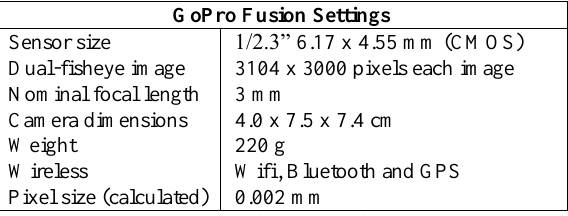
Table 1. Technical information of GoPro